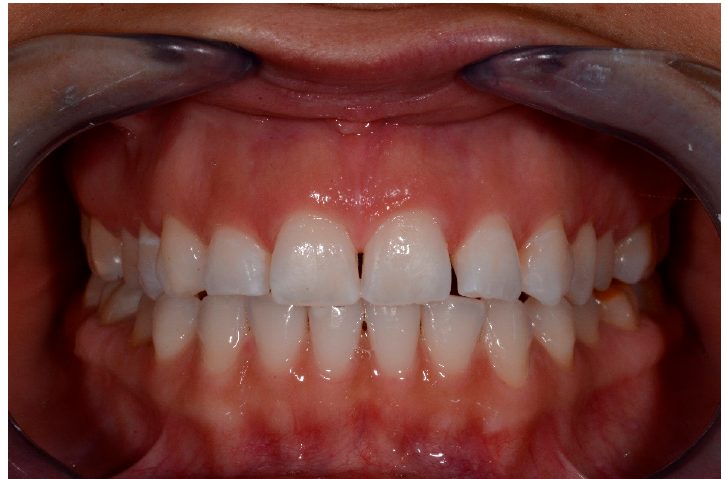
Figure 8. t2 lesions. Figure 6. t1 lesions. Figure 6. t1